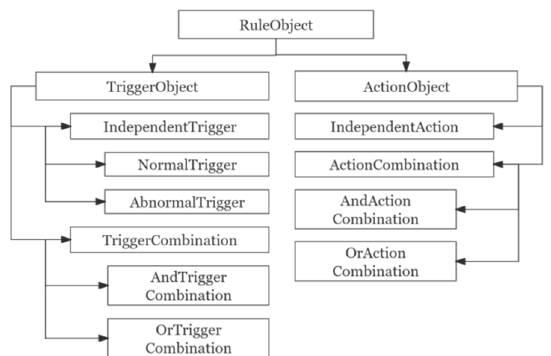
Figure 8. Schematic diagram of the conceptual hierarchy of knowledge inference rules.